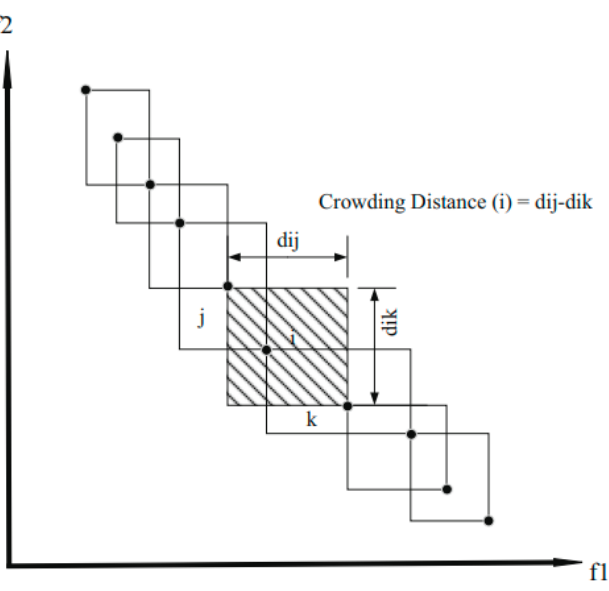
Figure 8. Calculation of crowding distance in NSGA-II.